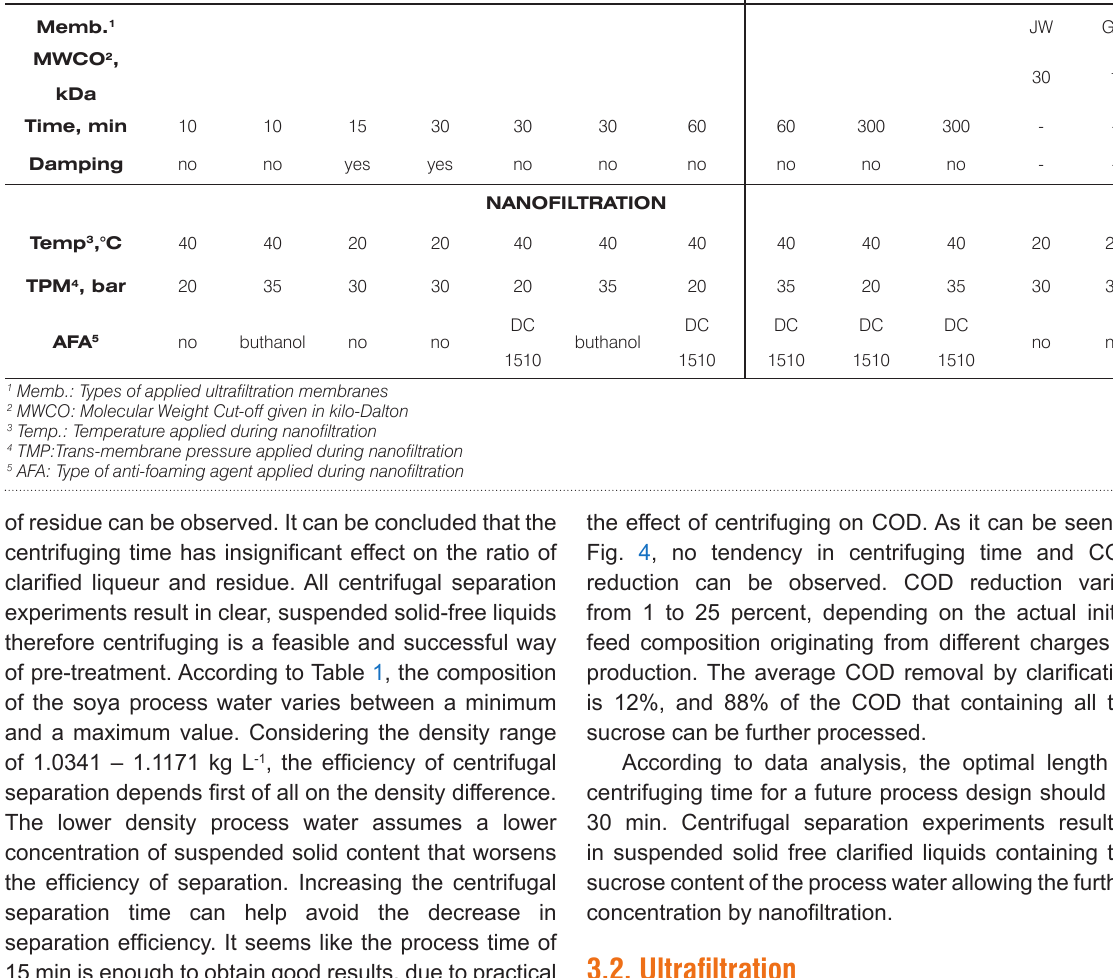
Table 3. Summary of experimental plan. Type of